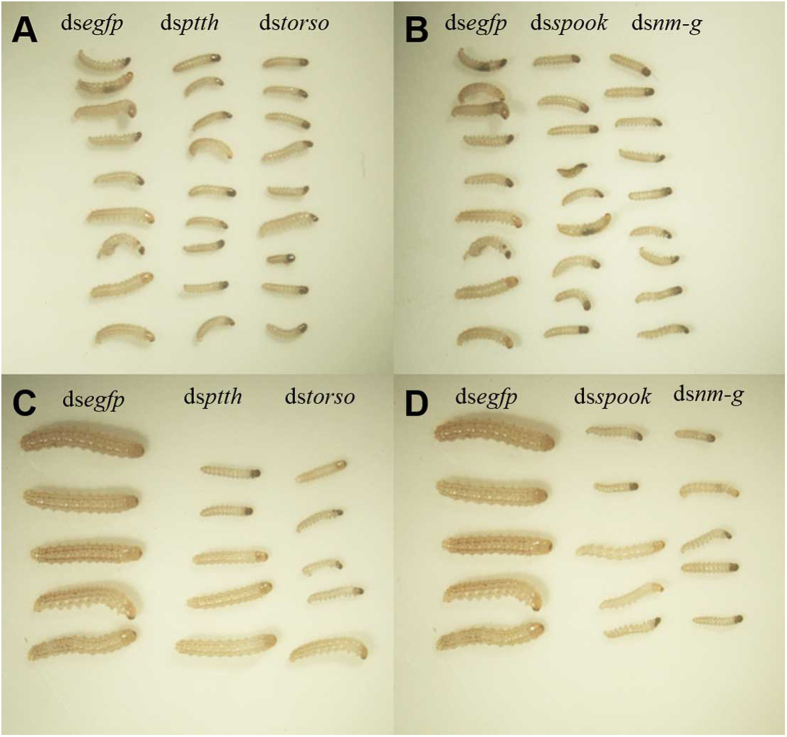
Retarded development in RNAi-treated groups.The surviving larvae in each RNAi-treated group showed retarded development. The group fed with dsegfp was used as the negative control. (A,B) were taken 2 days after feeding, (C,D) were taken after 7 days after feeding.